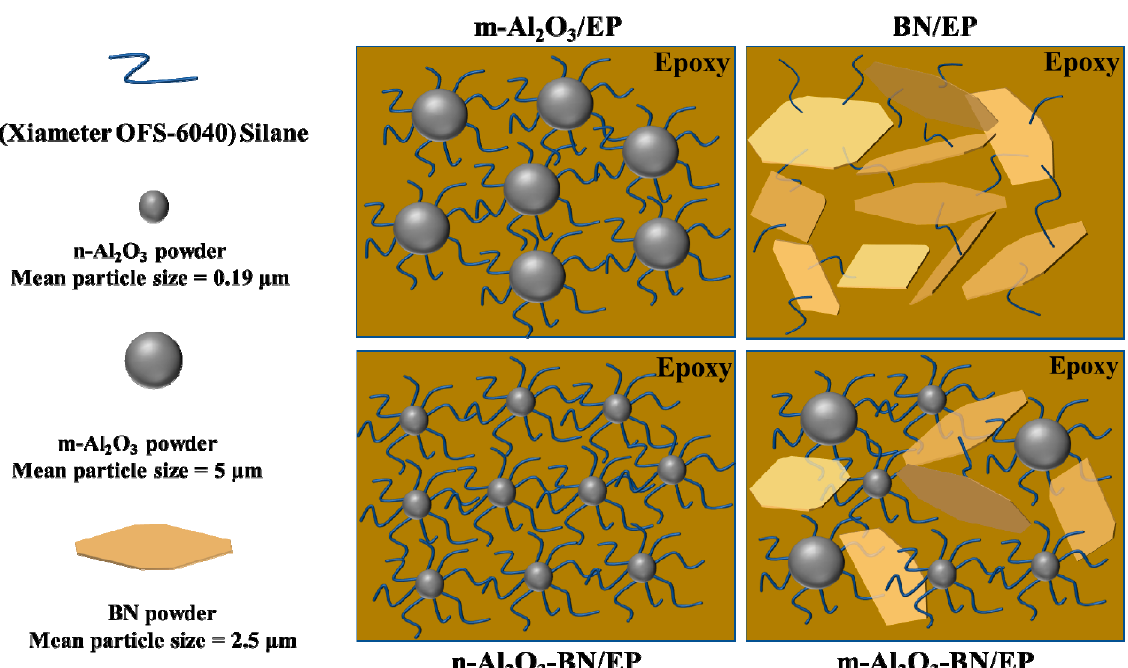
Figure 2. Schematic of the mechanism of surface modification for Al 2 O 3 and BN fillers with the epoxy binder system.